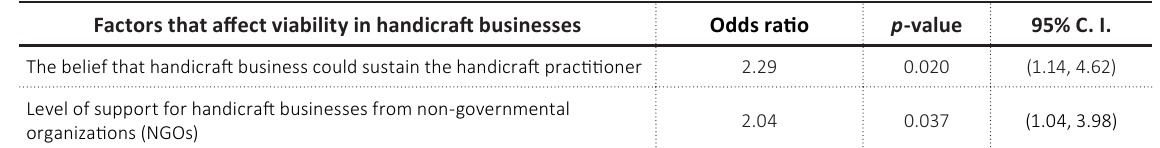
Table 6. Results obtained from logit